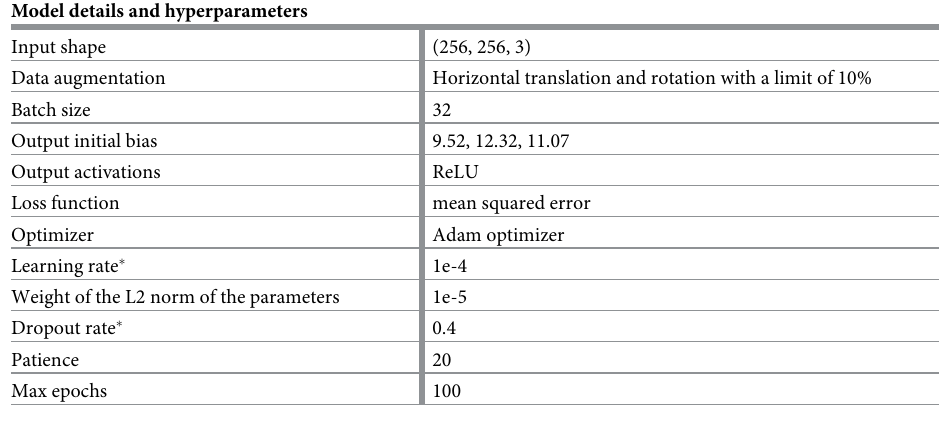
Table 1. Hyperparameters.